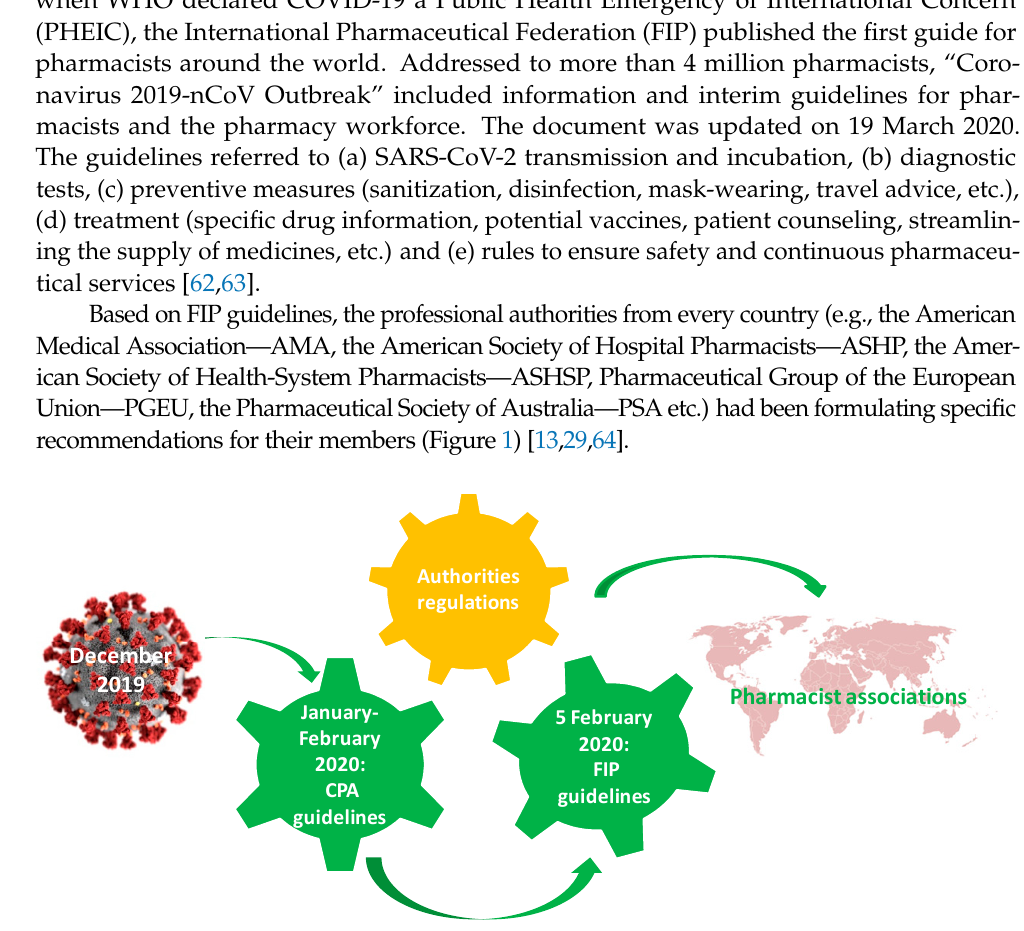
Figure 1. The mechanism of elaborating the pharmaceutical guidelines on COVID. CPA—Chinese Pharmaceutical Association; FIP—International Pharmaceutical Federation.